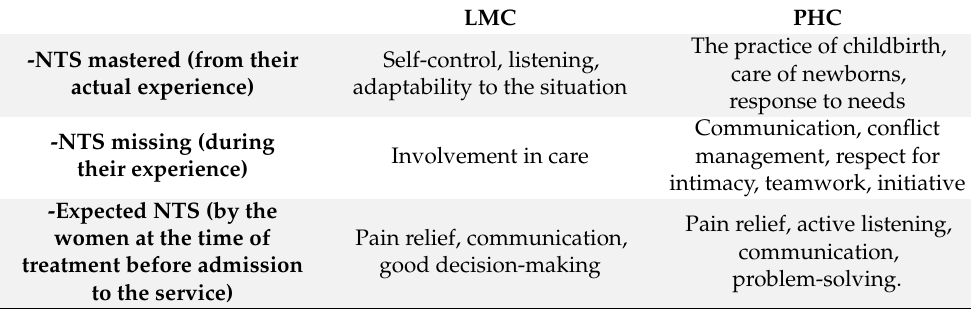
LMC PHC The practice of childbirth, Self-control, listening, care of newborns, adaptability to the situation response to needs Communication, conflict Involvement in care management, respect for intimacy, teamwork, initiative Pain relief, active listening, Pain relief, communication, communication, good decision-making problem-solving.